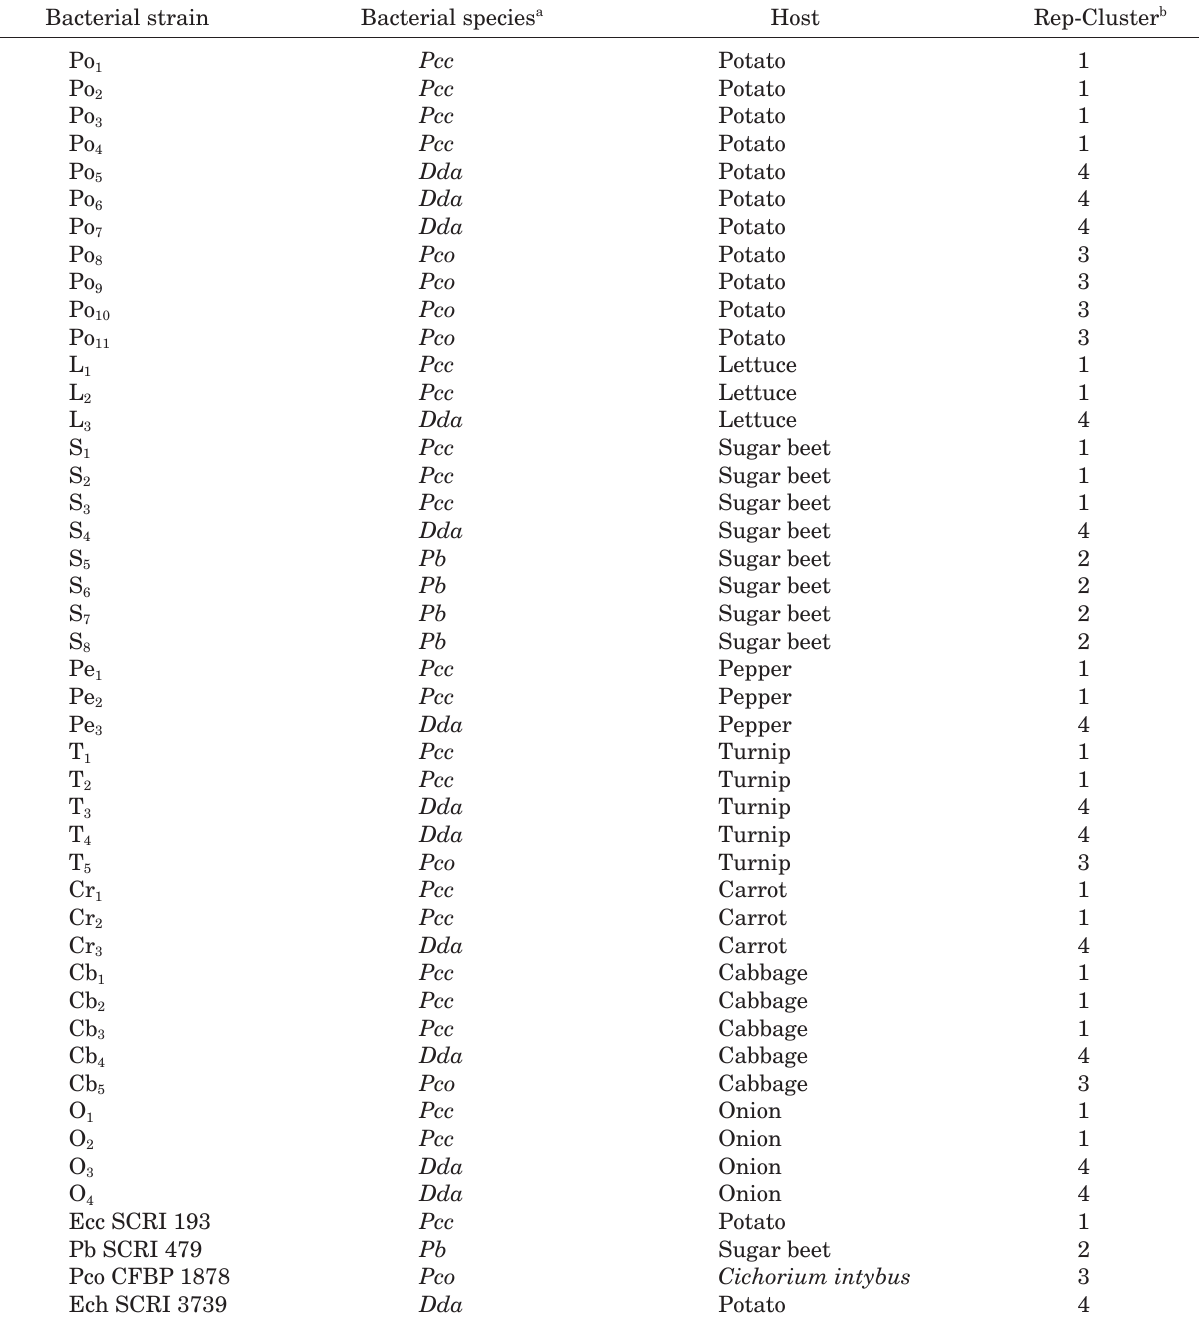
b Classification on the basis of biochemical and physiological properties. See Table 2. a Cluster analysis on the basis of REP-PCR with REP, ERIC and BOX primers. See Figure 4. c Pcc EccSCRI 193. d Pco CFBP 1878.